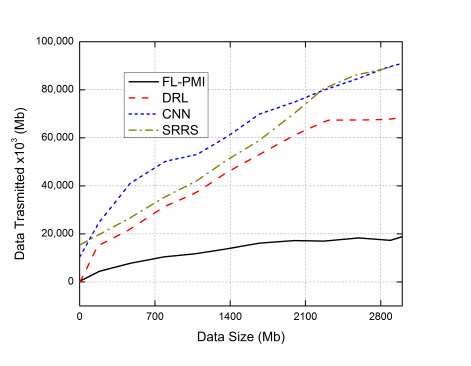
Figure 13. Comparative analysis of data transmitted concerning data